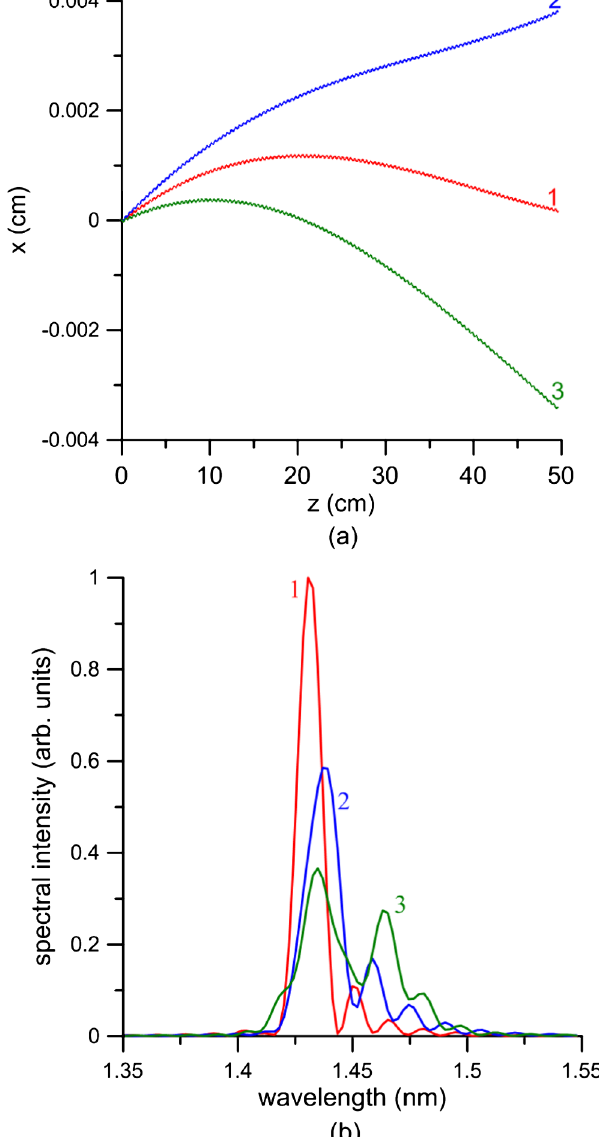
FIG. 4. Motion of test electrons with different injection phases with respect to the optimal phase ’ (a) trajectories of particles; (b) radiated spectra. (1) (cid:1) ’ ¼ 0 (cid:11) ; (2) (cid:1) ’ ¼ þ 10 (cid:11) ; and (3) (cid:1) ’ ¼ (cid:5) 10 (cid:11) .